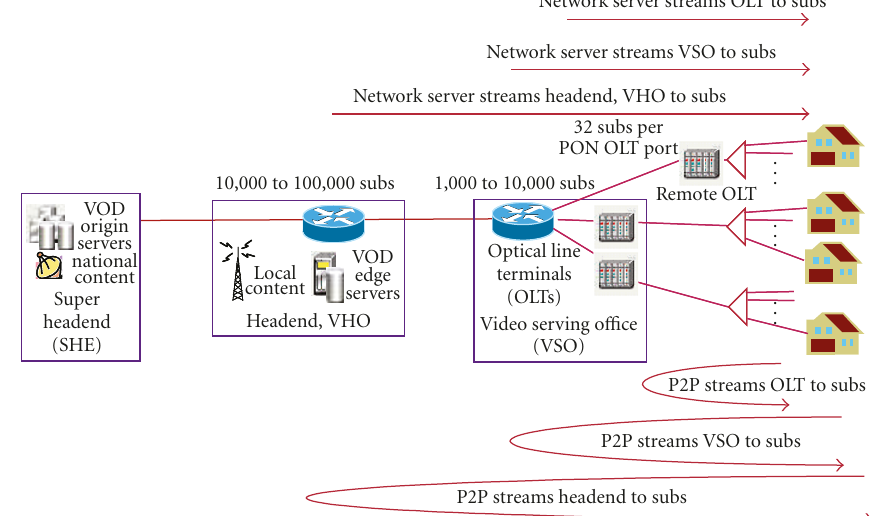
Figure 1: Localized Peer-to-Peer tra ffi c. The optical line terminal (OLT) is logically similar to a DSL access multiplexer (DSLAM), except that the DSLAM typically serves several hundred subscribers.